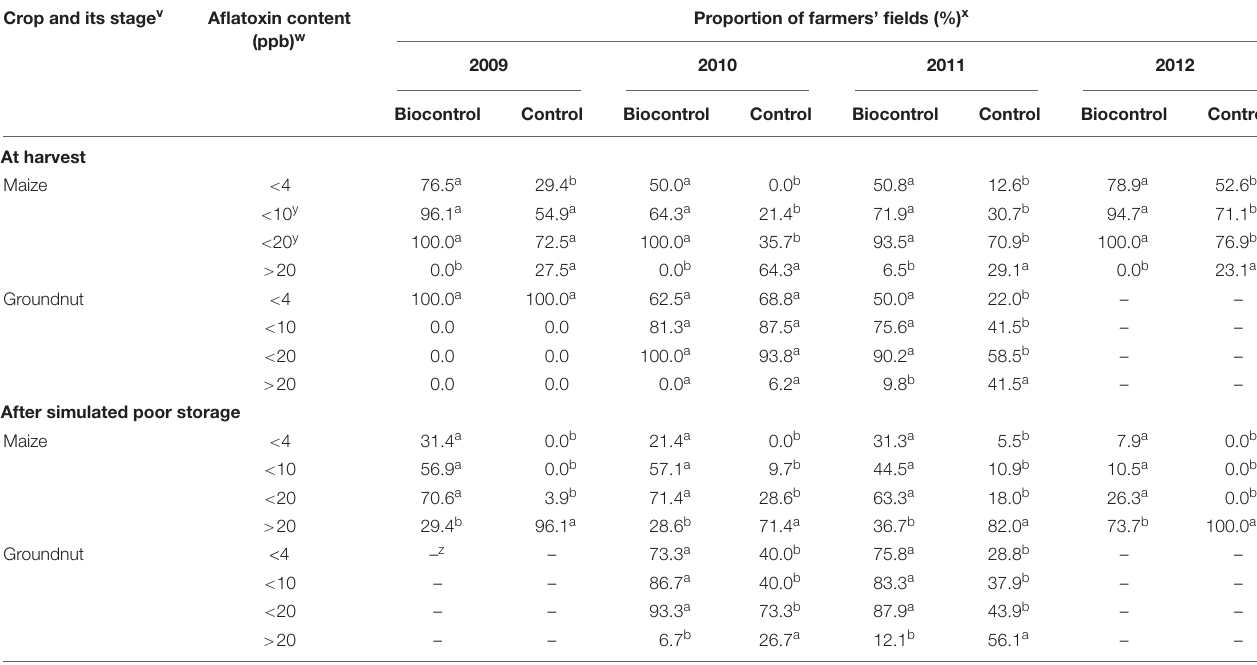
TABLE 8 | Proportion of farmers meeting various total aflatoxin standards in freshly harvested and poorly stored maize and groundnut grains from farmers’ fields that were either treated or not treated (control) with a biocontrol product in Nigeria during 2009 to 2012 u . Crop and its stage v